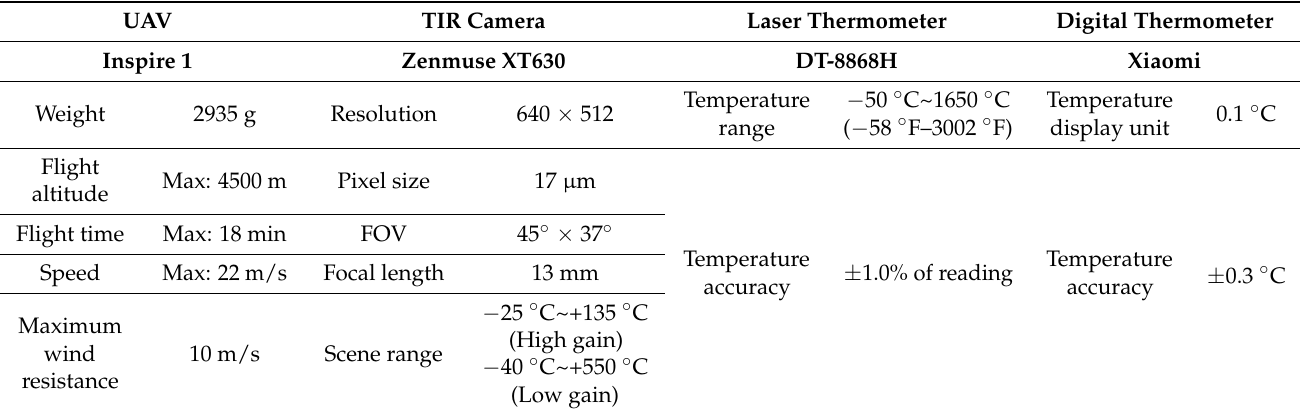
Table 1. UAV, TIR camera, laser thermometer, and digital thermometer specifications.